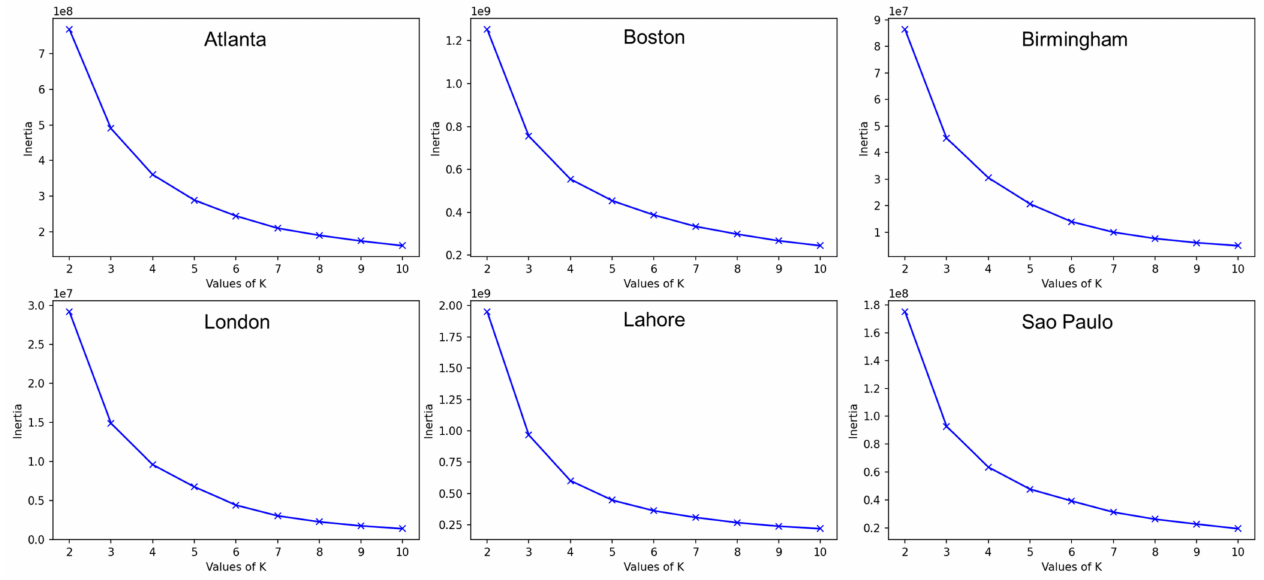
Figure A3. Cluster analysis results. Elbow curves based on the cluster inertia for the RGB values of the historical map raster datasets for the six study